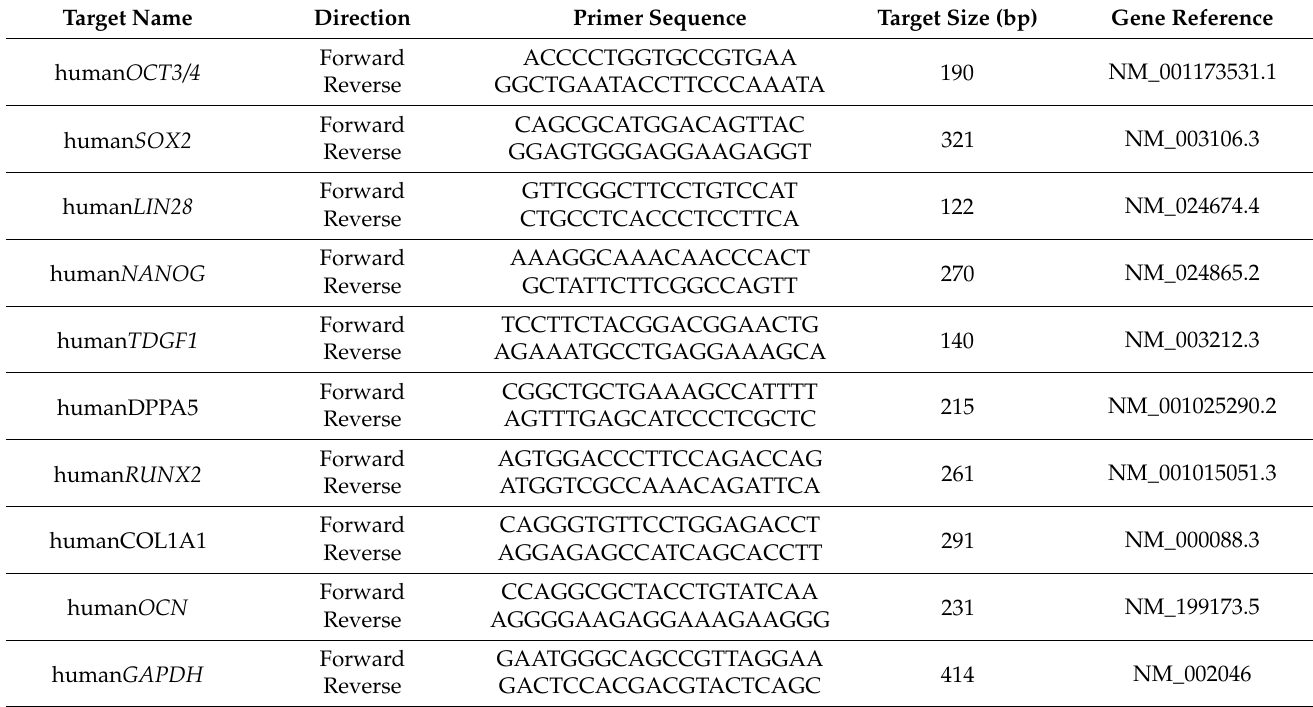
Table 2. List of PCR primer sequences used for RT- PCR and qRT-PCR